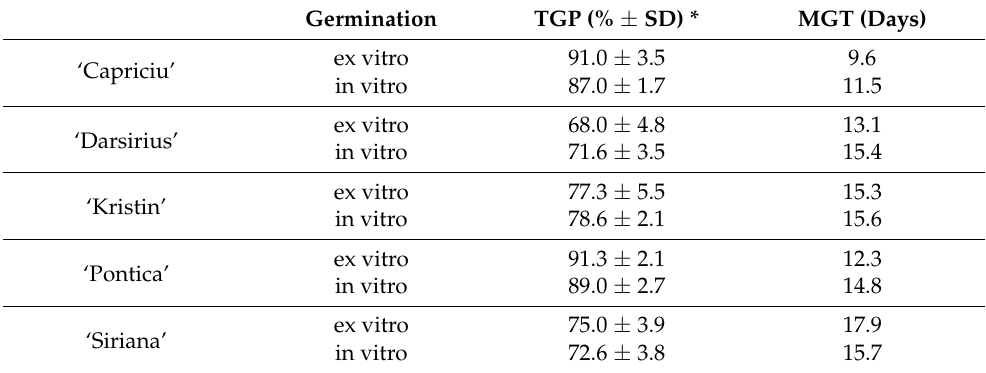
Table 1. Ex vitro and in vitro germination of tomato seeds, 25 days after transfer to germination substrate.